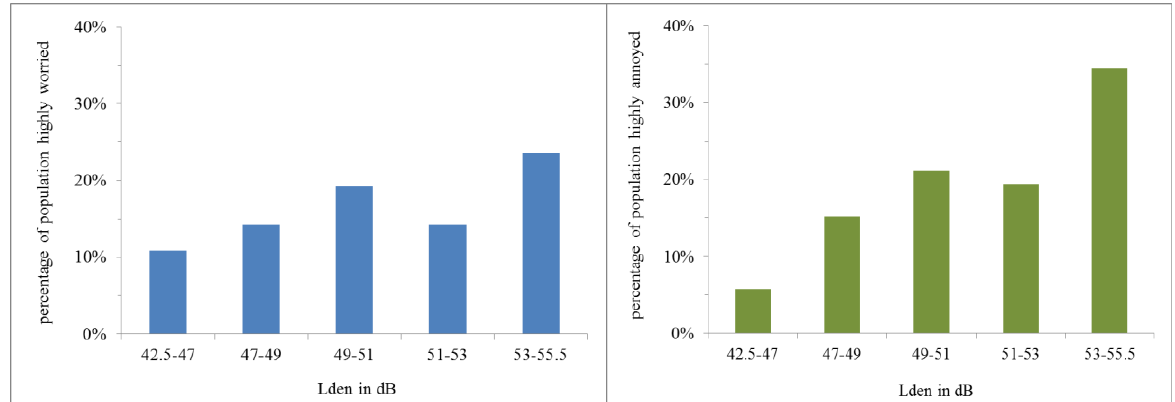
Figure 6. Left: percentages of population highly annoyed by aircraft noise in five categories of aircraft noise level L den . Right: percentages of respondents that are highly worried about living close to an air